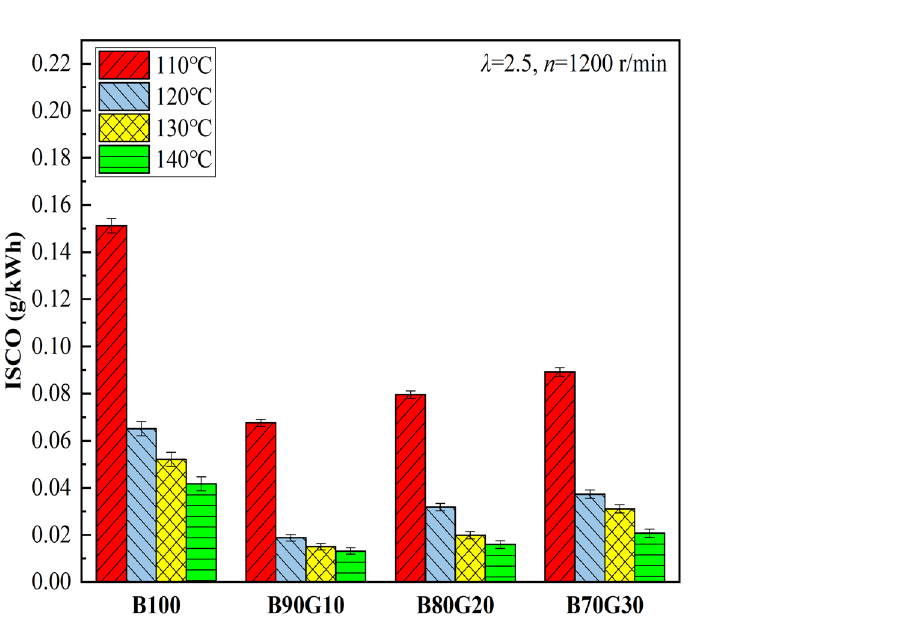
Figure 17. NOx emissions with different T in s.